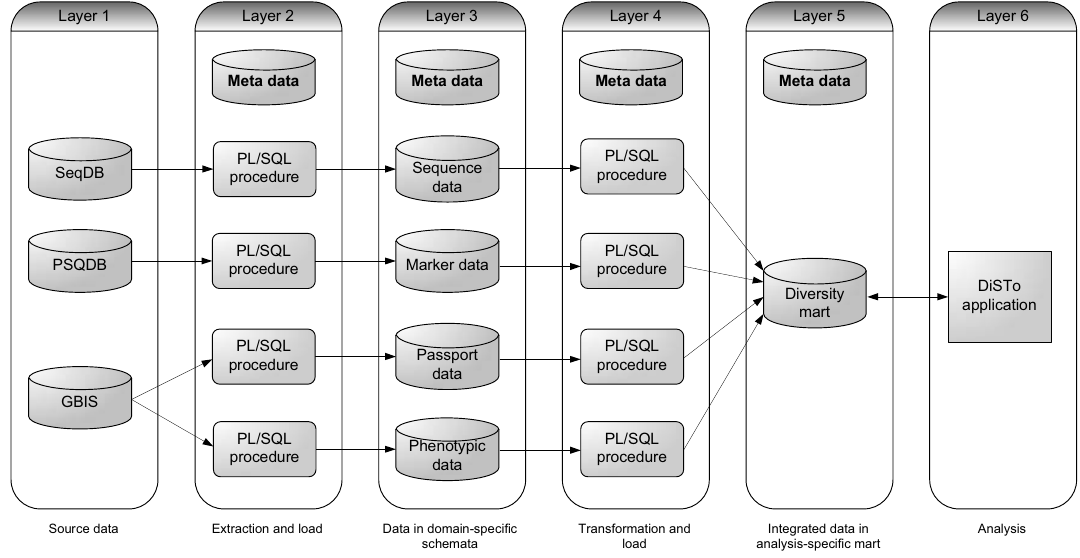
Figure 4: Implementation of our architecture for the DiSTo